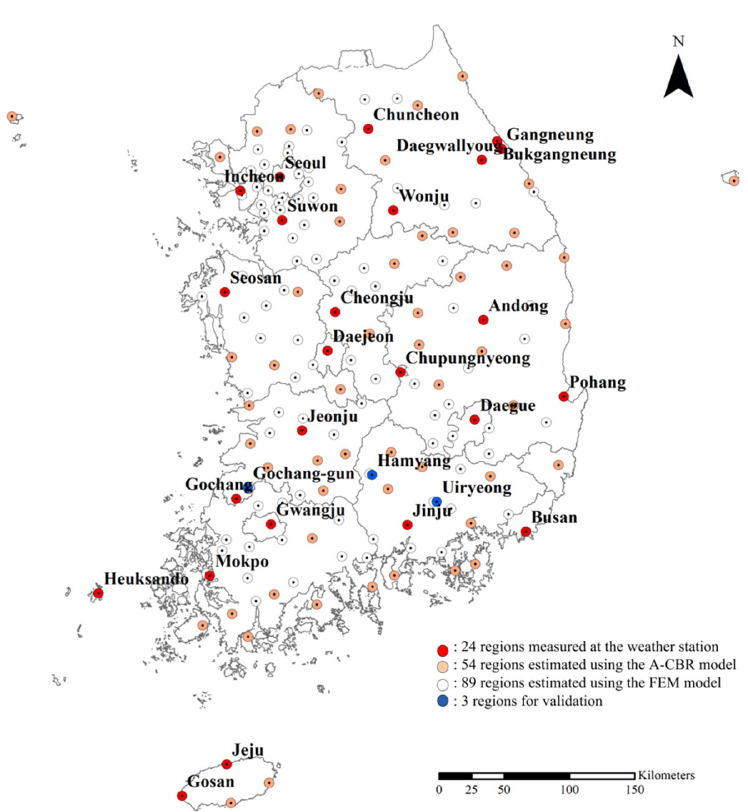
Fig. 3. Geographic locations used for developing the MADSR